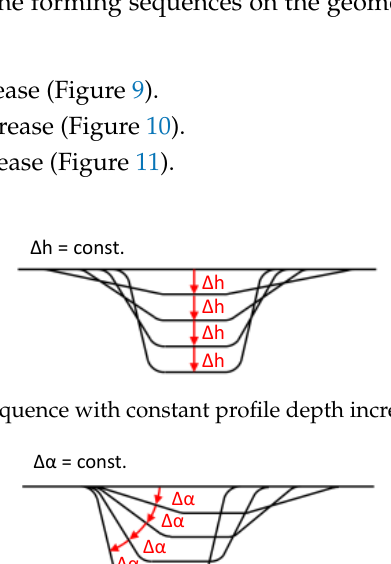
Figure 10. Forming sequence with constant bending angle increase in each roll pass.